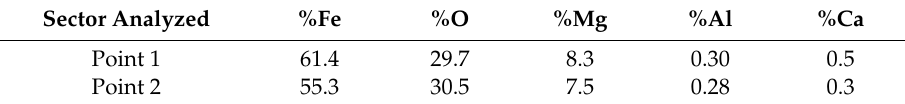
Table 2. EDS analysis, in atomic